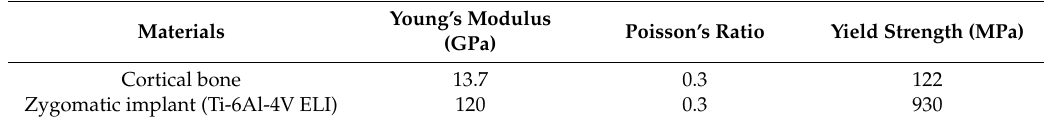
Table 1. Material properties utilized in the finite element analysis model [40,41].